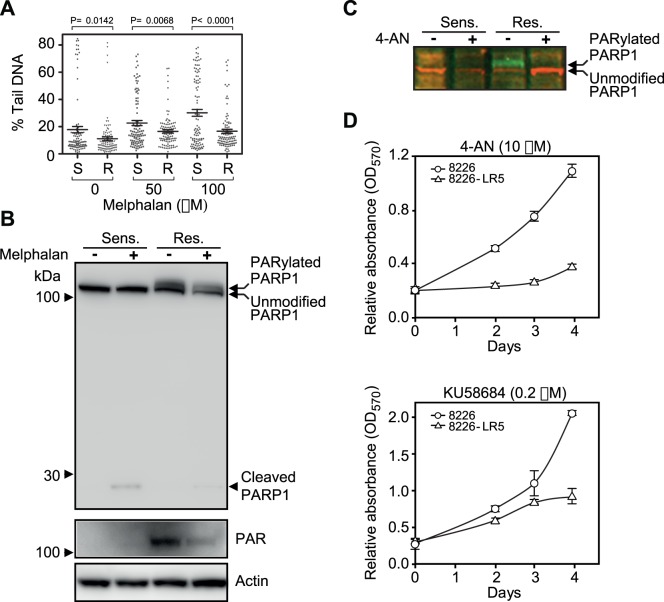
Assessment of alkali-labile sites in Melphalan sensitive and resistant cells.(A) Comet assays demonstrated that the resistant LR cells contained a significantly lower number of alkali-labile sites than the sensitive cells both at steady-state and subsequent to high-dose melphalan treatment. Per cent tail DNA of the comets is presented in dot plots with average and corresponding SEM. P values were calculated using an unpaired two-tailed t-test. R: resistant, S: sensitive. 100 comets were randomly selected and evaluated from one experiment at each treatment. (B) Western blot analysis showed that PARP-1 is activated via poly-ADP(ribosyl)ation only in the resistant cells suggesting that SSB repair and potentially also DSB synapsis is enhanced in the resistant cells. (C) Activation of PARP1 by PARylation in the resistant LR5 cells was completely abolished subsequent to treatment with the PARP-1 inhibitor 4-AN. (D) Inhibition of PARP-1 by 4-AN or KU58684 obstructs the proliferation of resistant cells while having a minor effect on the sensitive cells.